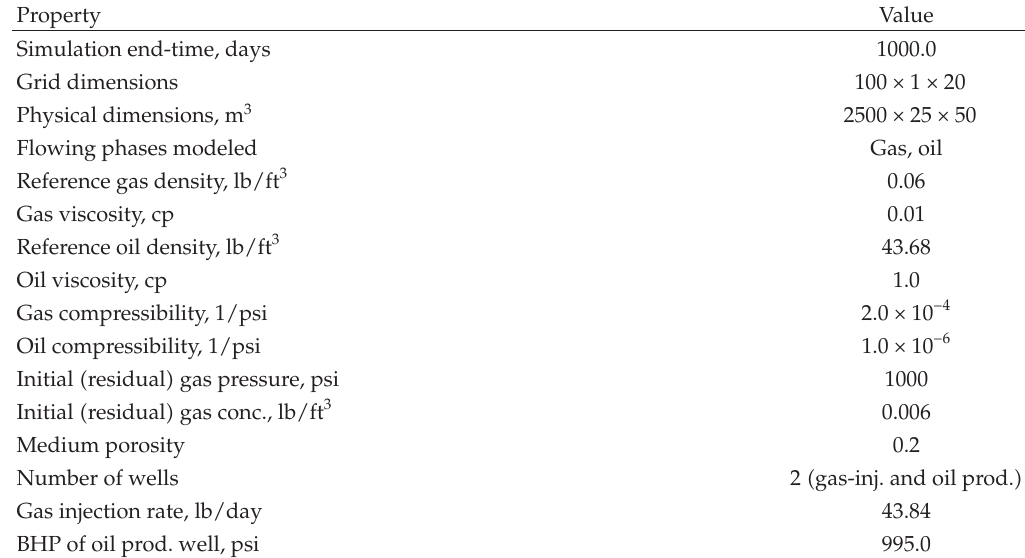
Table 1: Parameter estimation: data for example 1, (cid:6) based on 10th SPE permeability set (cid:7)